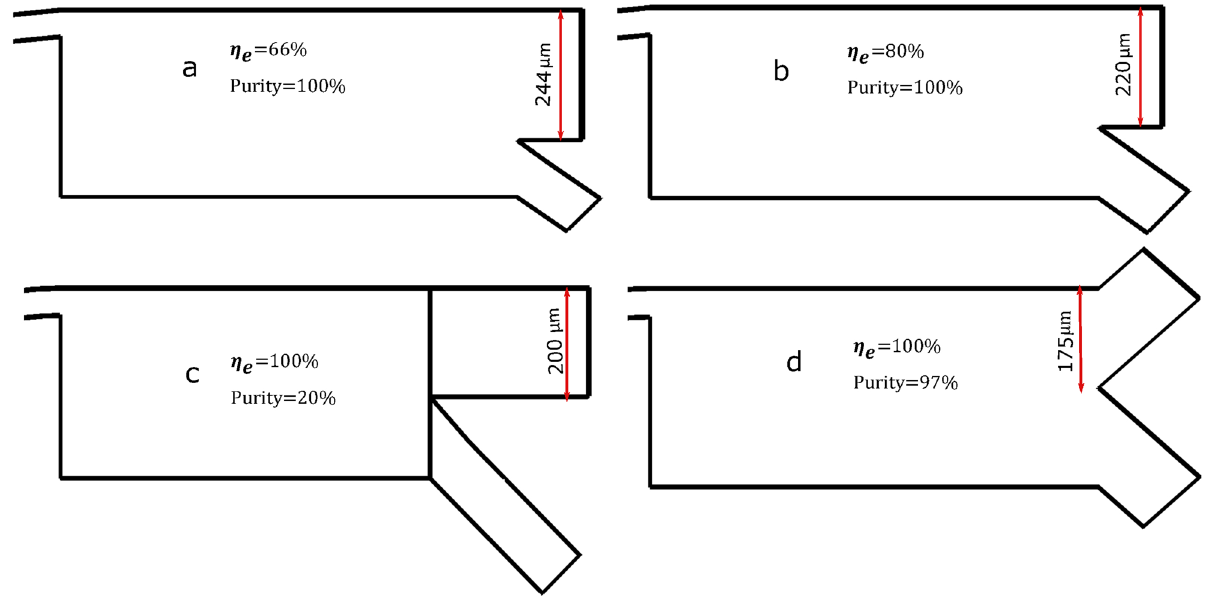
Figure 6. Different designed outlets highlight the selection of inertial focusing phase. To visualize the separation efficiency particles are colored according to their sizes. ( a ) Outlets are designed based on the concentration gap of particles in the initial model. ( b ) Outlet sizes altered ( c ) Waste outlet size increased ( d ) Symmetric bifurcation of the outlets results in the effective separation of CTC from rest of the blood